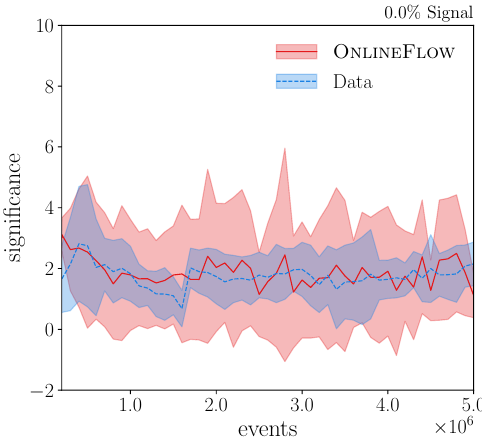
Figure 7: Fake signal significance as a function of the amount of training data for the classical approach, based on all training data, and the O NLINE F LOW . The analysis is identical to that of Fig. 6, but with zero signal